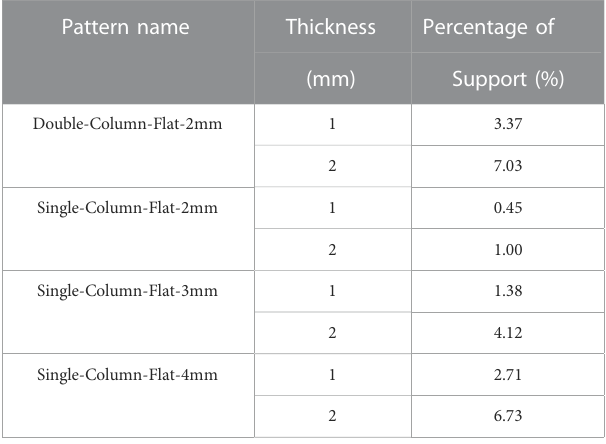
TABLE 8 Percentage of torque generated by intervertebral disc in fl exion